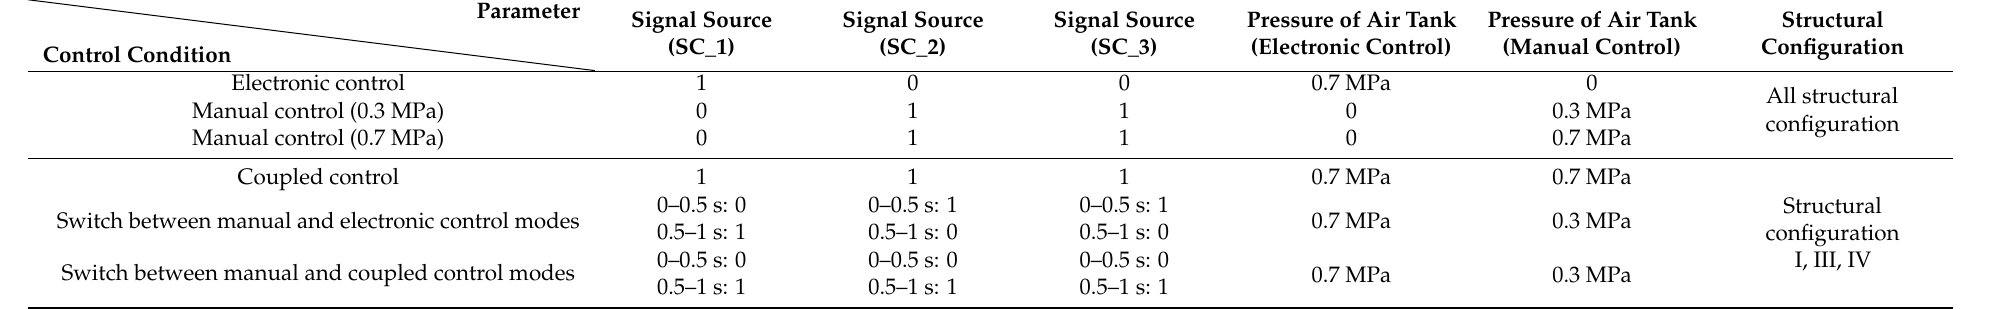
Table 6. Parameters of the simulation models for the pressure regulation characteristics of the APRV of the different structural configurations in the ECPBS of commercial